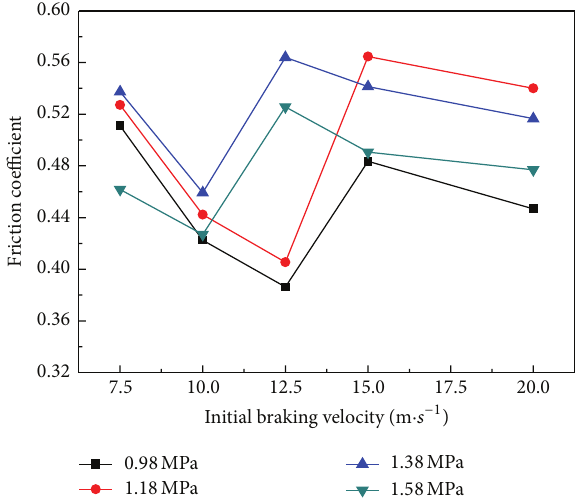
Figure 3: Variations of the mean friction coefficient with initial braking